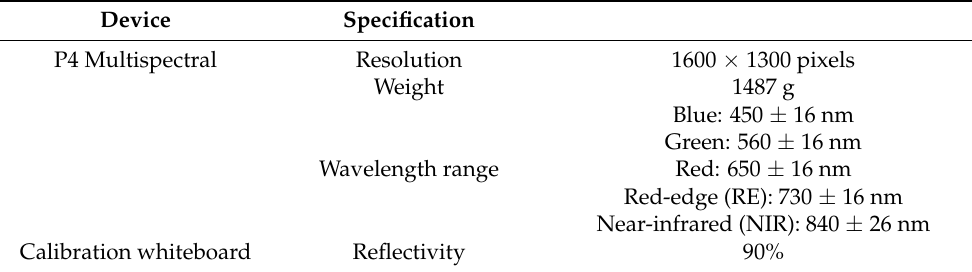
Table 2. Multispectral image acquisition system parameters.